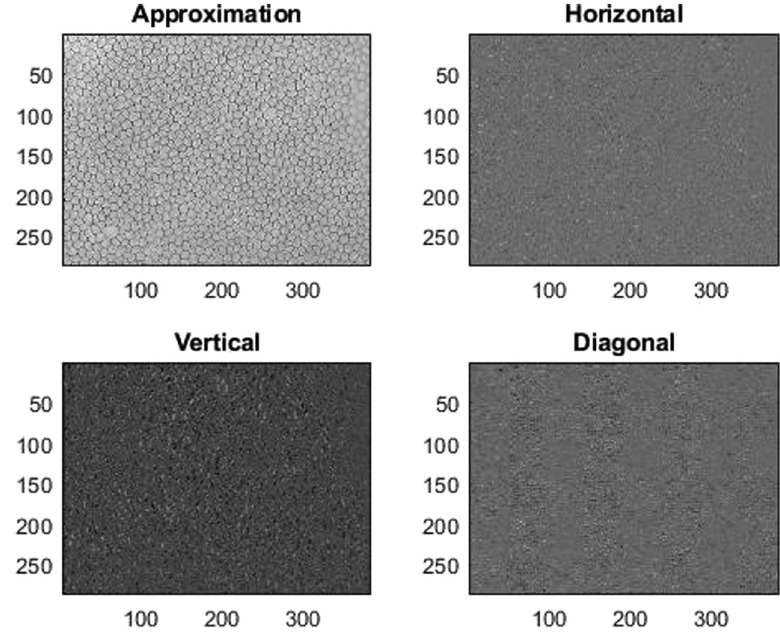
Figure 8: Sub - bands for the vertical, diagonal, approximation, and horizontal information concerning the